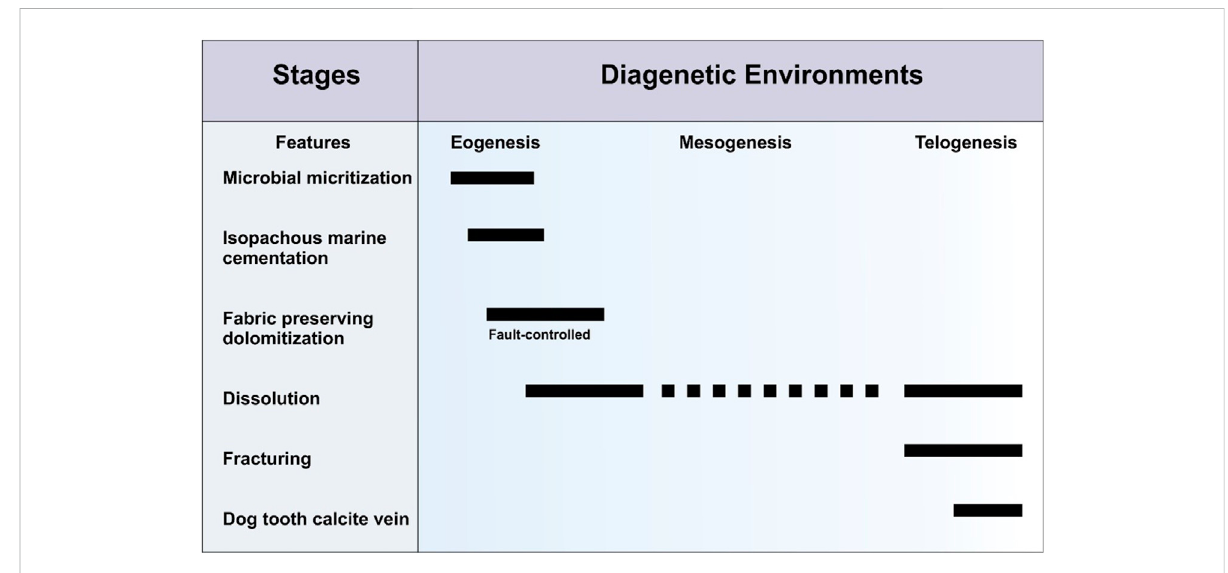
FIGURE 6 Paragenetic sequence of the study